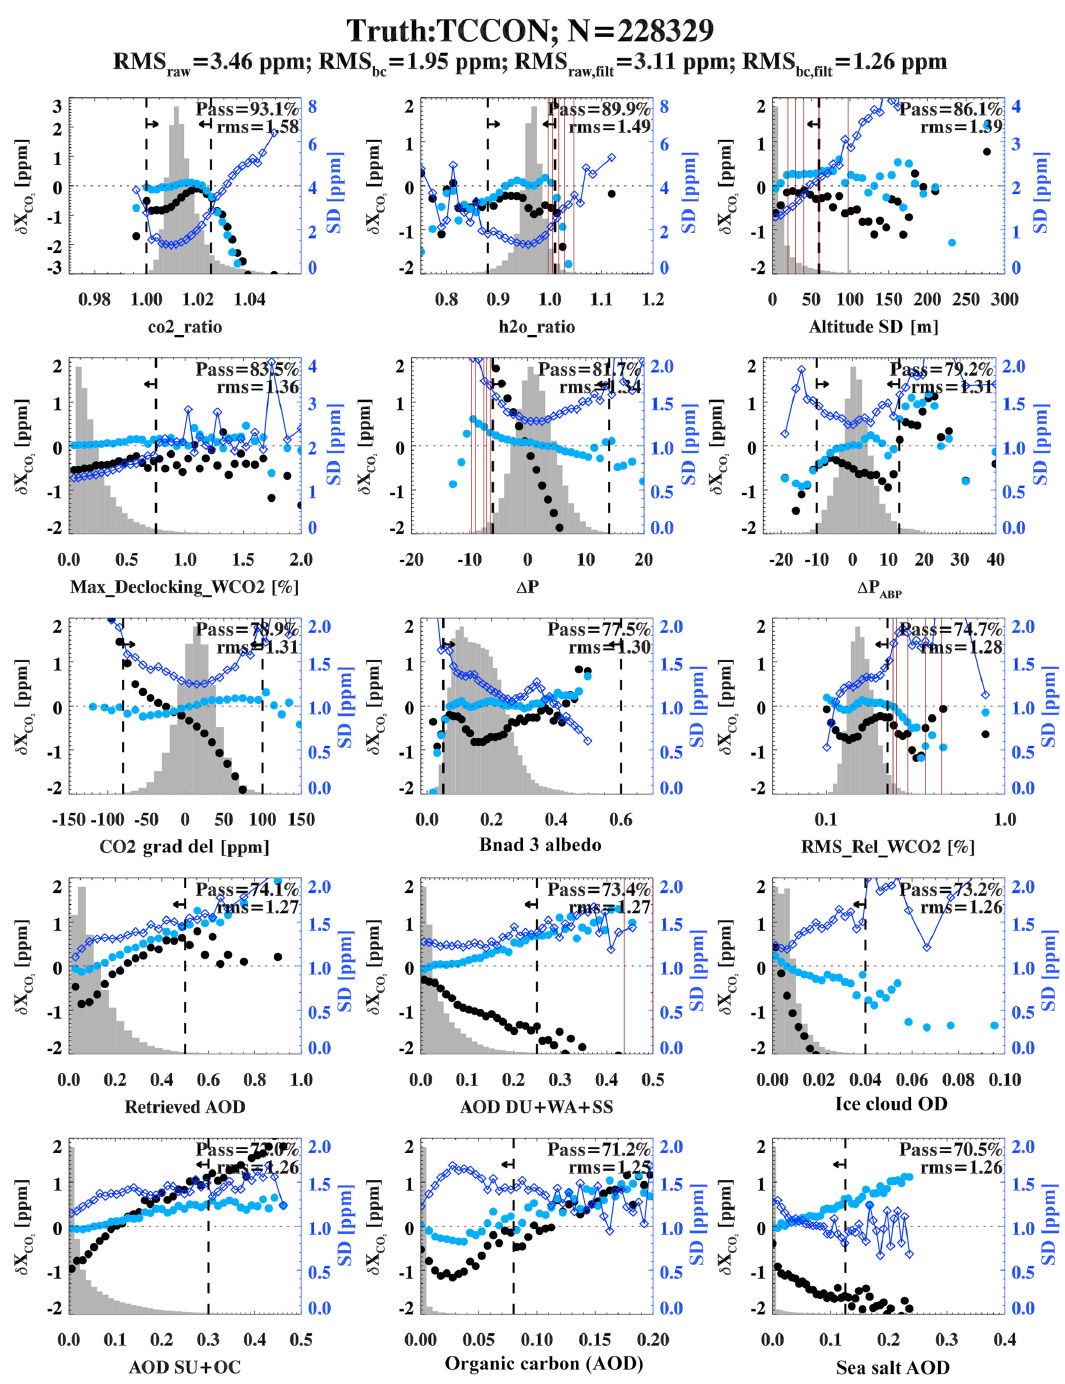
Figure 10. δX CO versus select filtering variables for land (nadir + glint) data, using TCCON as a truth proxy. Shown are the mean bias in 2 each parameter bin for both raw (black circles) and bias-corrected (light blue circles) X CO corrected δX CO (dark blue diamonds). The histogram of each parameter is shown in gray. The vertical black dashed lines denote filtering 2 thresholds for the X CO quality flag, while the thin red solid lines show filtering thresholds for the warn levels. The quality flag filters are 2 applied cumulatively from left to right and top to bottom. The fraction passing at each step, as well as the rms error of the bias-corrected X CO , are shown in the upper right corner of each panel. Please see Table A1 for a complete definition of all of the filter 2